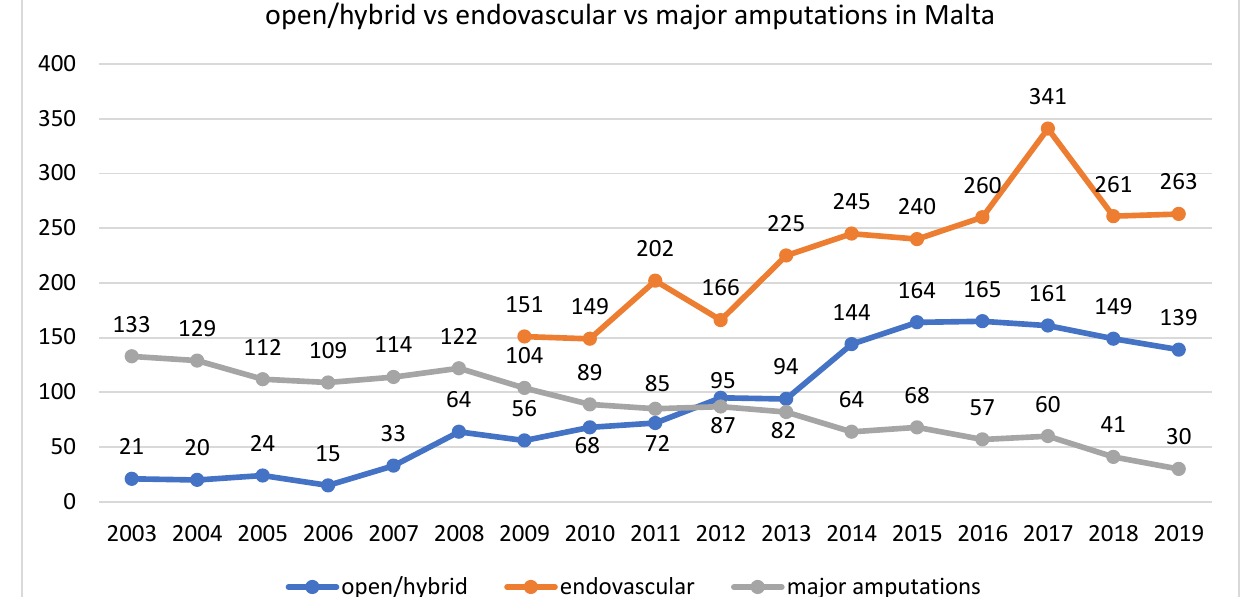
Figure 5. Comparison of open revascularization procedures with major amputation rate between 2003 and 2019.